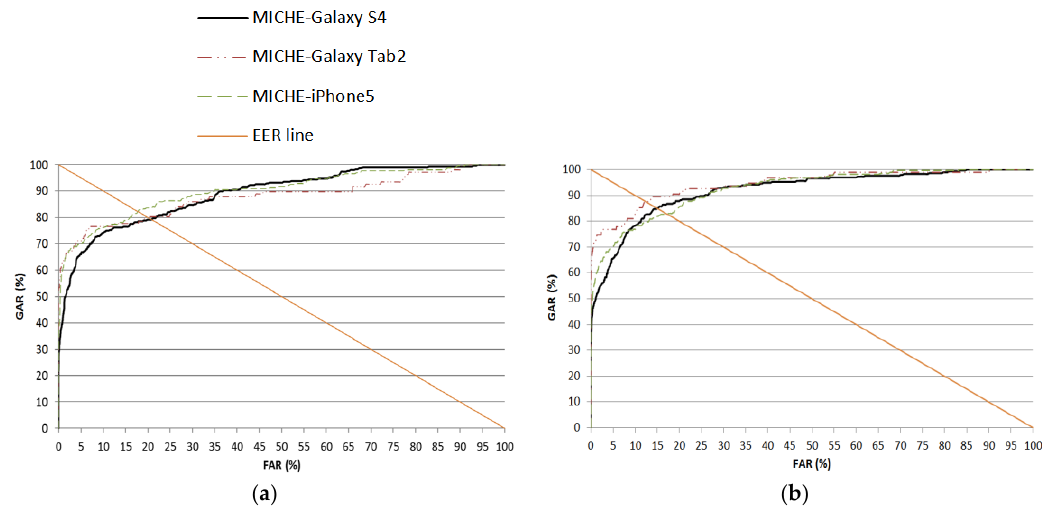
Figure 11. ROC curves of iris recognition in the three sub-datasets of the MICHE database including the data from indoors and outdoors. ( a ) First fold cross-validation; ( b ) second fold cross-validation.